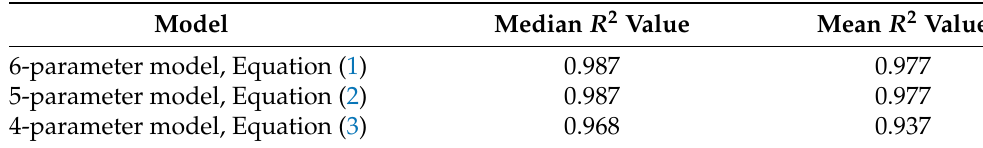
Table 2. Comparison of the fitting result of the three considered LDC